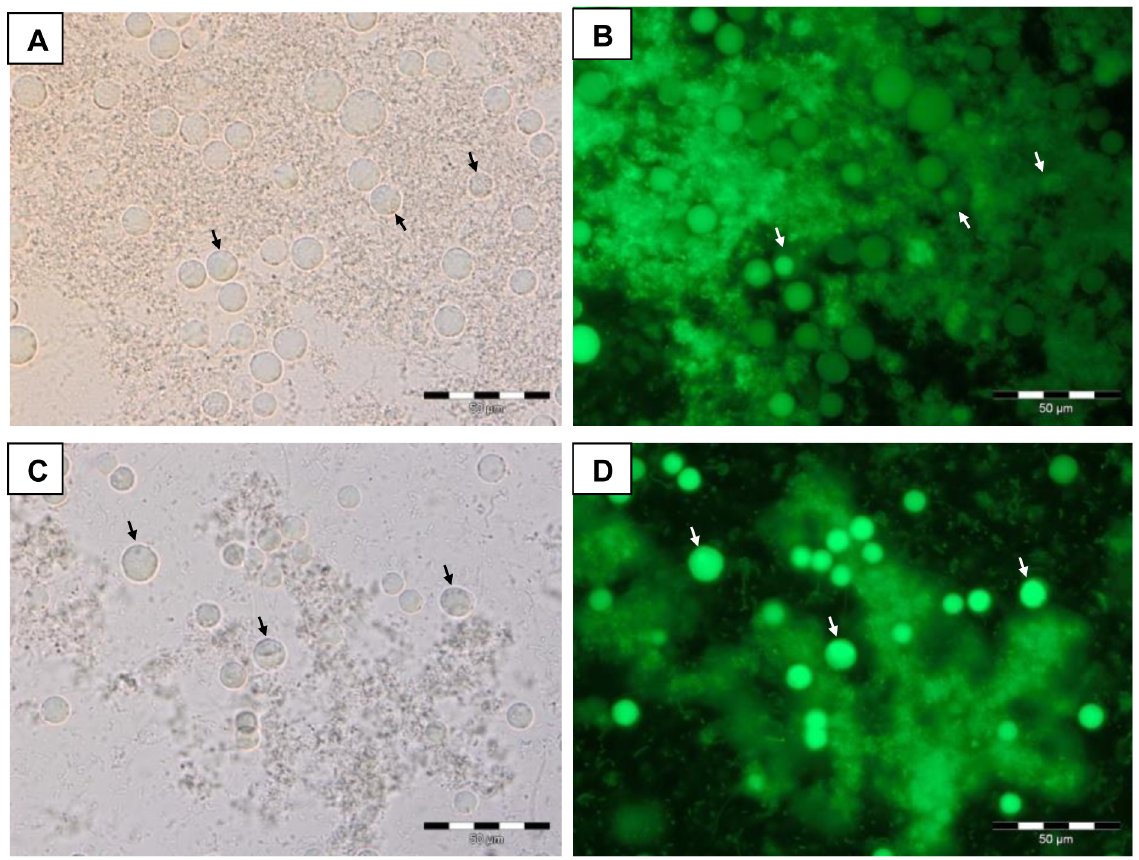
Figure 3. Bright field and epifluorescence images of Blastocystis sp. stained with acridine orange ( 6 400). Image A and B is the control isolate at 37 u C, while C and D is the thermal stressed isolate at 41 u C. Note: The vacuolar forms in control isolates are stained dull green (Image B), and the granular form (arrow) in thermal stressed isolates are stained bright green (Image D).